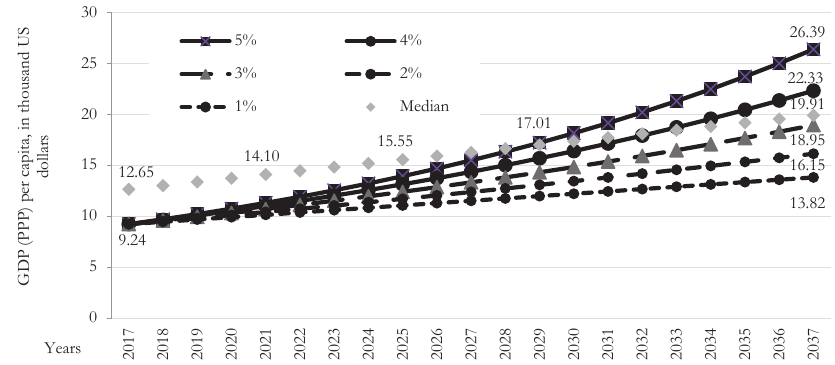
Fig. 13 – Model curves with different growth rates of GDP (PPP) per capita compared to worldwide median growth rates. Source: own calculations